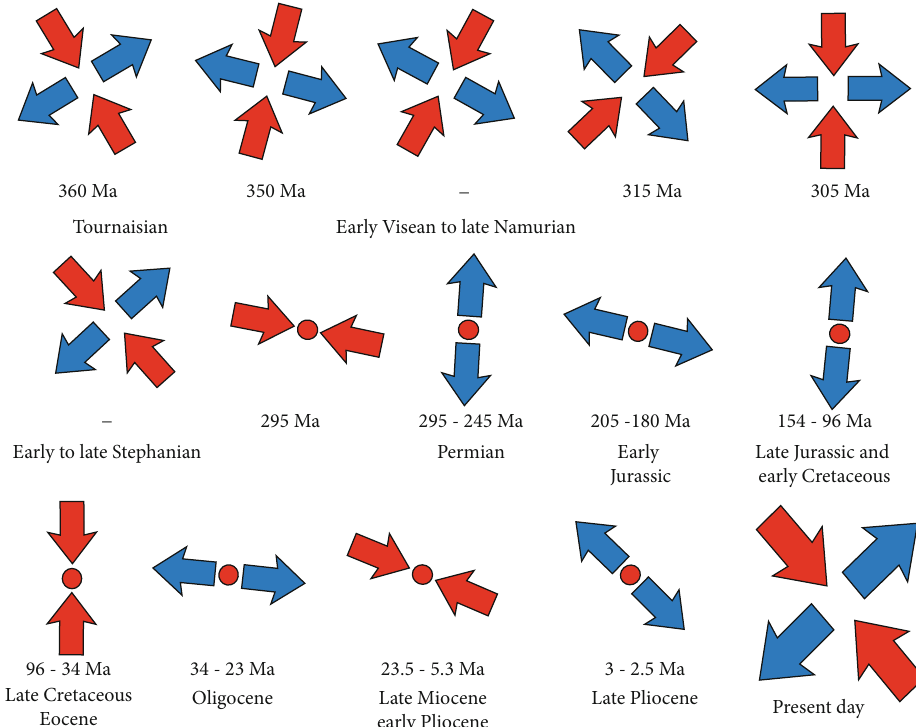
Figure 2: Paleostress orientation in the “ La Sioule ” licence since the Tournaisian (360Ma). Blue arrows indicate the extensional direction. Red arrows indicate the compressional direction (modi fi ed after [59, 65,